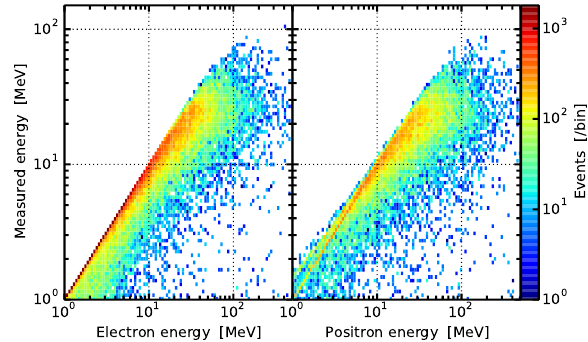
Figure 4. Detector response for stopping electrons (left) and positrons (right). The figure shows the measured energy versus the initial energy of the electron/positron for an isotropic distribution of particles and energy spectra obtained with Planetocosmics. The color denotes the number of measured particles per